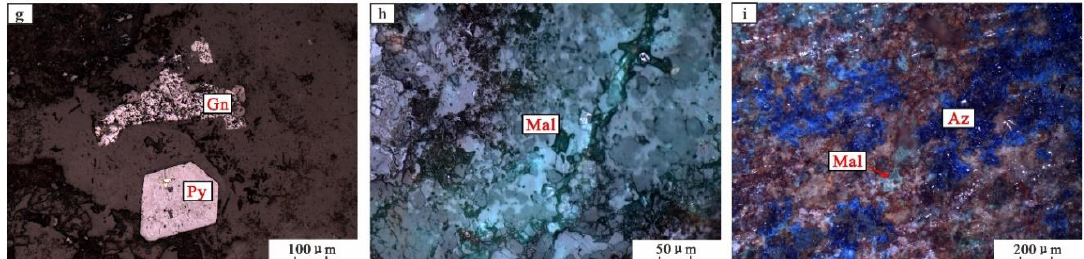
Figure 2. Photomicrographs of typical rocks in Central Nuocang. ( a ) Dacitic breccia; ( b ) intermediate – acidic volcanic breccia; ( c ) rhyolite porphyry; ( d ) dacitic breccia tuff; ( e ) rhyolitic breccia tuff; ( f ) debris quartz sandstone; ( g ) galena and pyrite in rhyolite porphyry; ( h ) disseminated malachite in alteration zone; ( i ) intergrown malachite and azurite in rhyolite porphyry. Abbreviations: Pl, plagioclase; Q, quartz; Kf, potassium feldspar; Cbn, carbonatite; Gn, galena; Py, pyrite; Mal, malachite; Az, azurite.